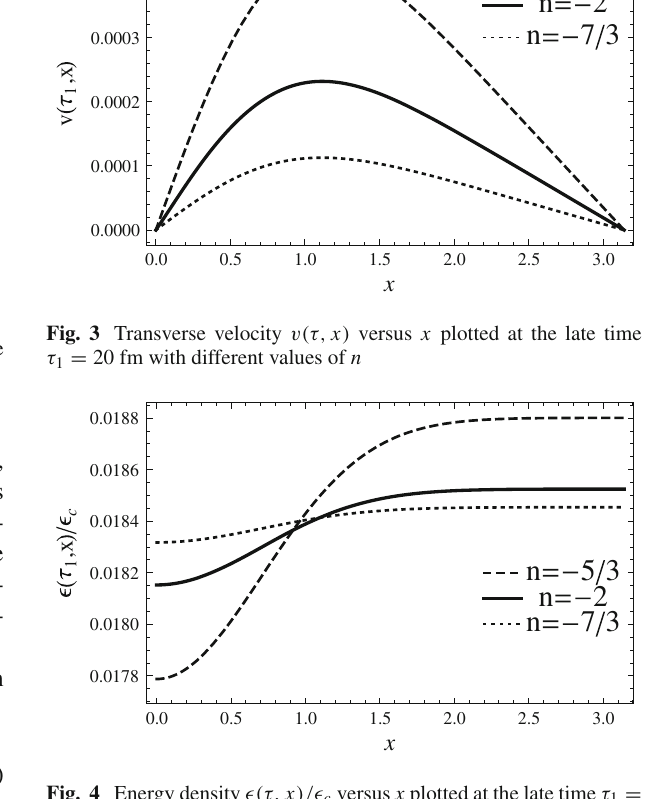
Fig. 4 Energy density (cid:3)(τ, x )/(cid:3) c versus x plotted at the late time τ 1 = 20 fm with different values of